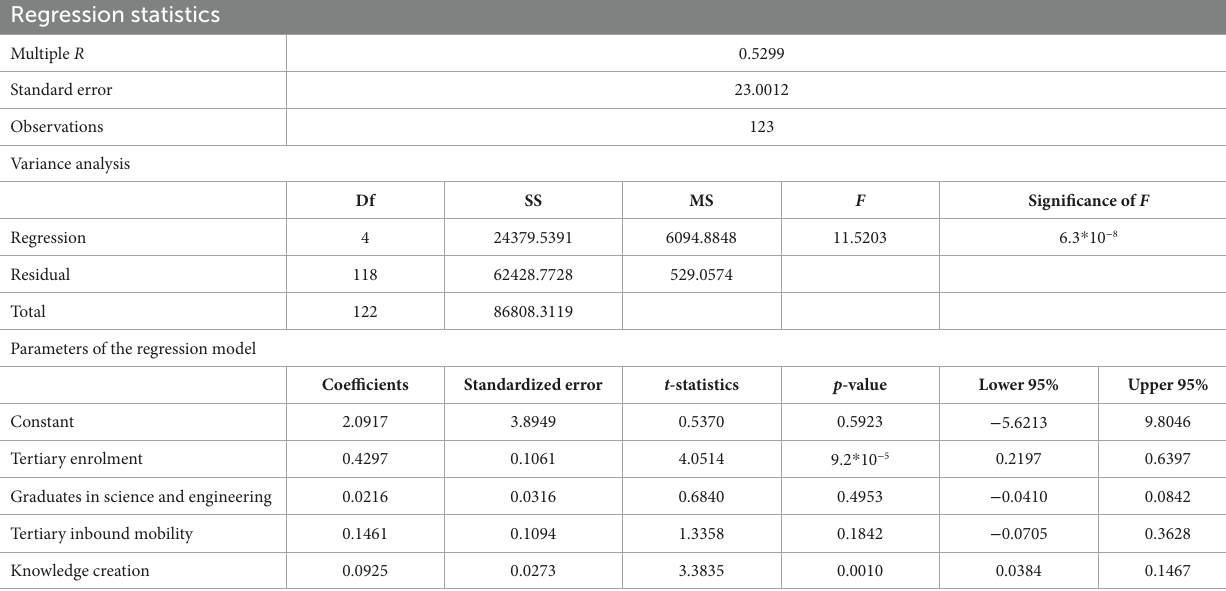
TABLE 2 Regression analysis of QS university ranking, top 3, on university governance factors in 2022.